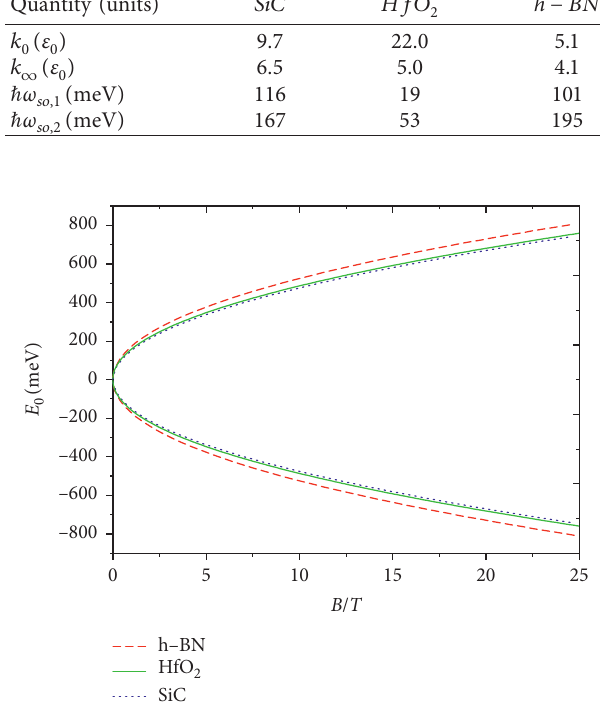
Figure 2: Variable magnetic field B versus the ground energy E